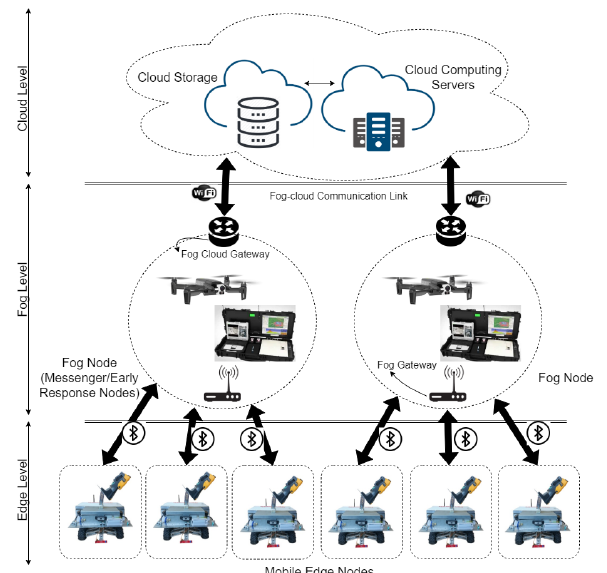
Figure 3. Edge-fog-cloud architecture for the communication needs of autonomous industrial